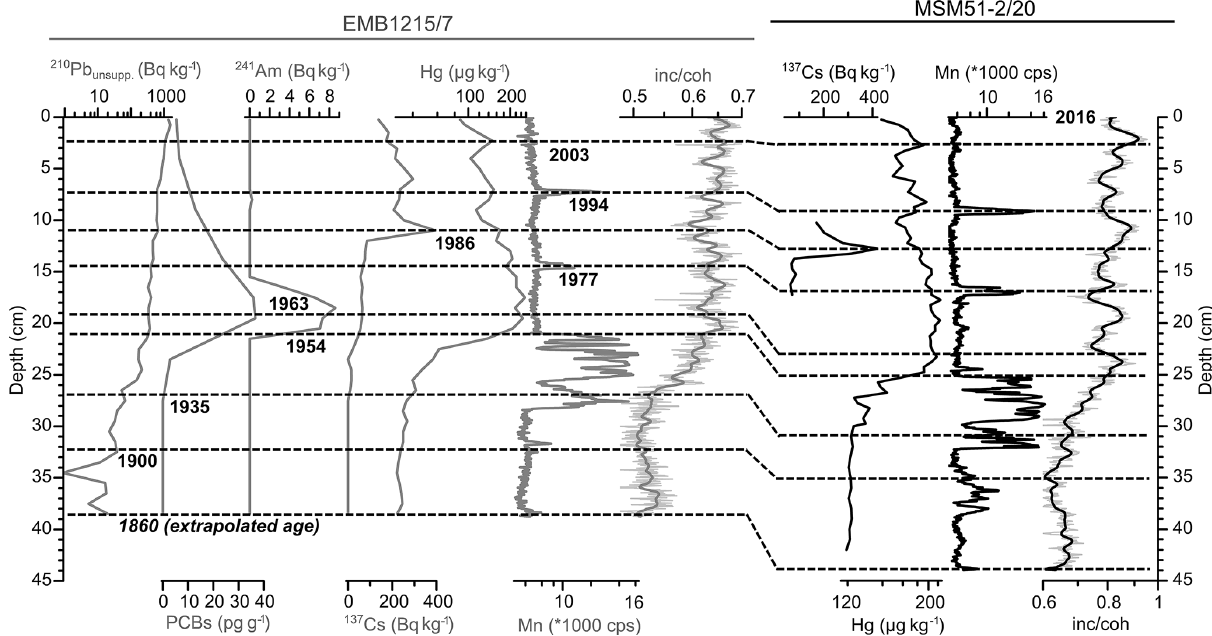
Figure 2. Age models of short sediment cores EMB1215/7 (grey curves) and MSM51-2/20 (black curves) based on records of pollutants (mer- cury, Hg; sum of polychlorinated biphenyls, PCBs), radionuclides (unsupported 210 lead, 210 Pb unsupp . ; 241 americium, 241 Am; 137 caesium, 137 Cs), and XRF-scanning elements (Mn in counts per second and the inc / coh ratio). The dashed lines represent core EMB1215/7 depths dated by event stratigraphy (year CE) as published in Moros et al. (2017) (except for the PCBs record) and their equivalent depths in core MSM51-2/20. The data are listed in Table